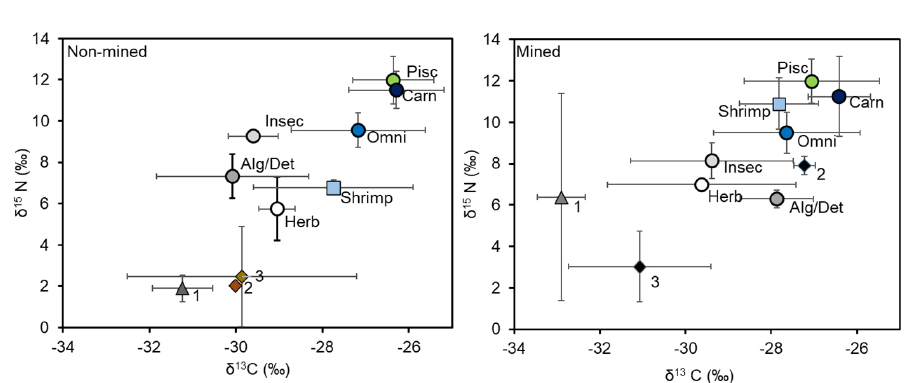
FIGURE 4 | Mean nitrogen ( δ 15N) and carbon ( δ 13C) isotope ratios of fish species collected from mined (right panel) and non-mined (left panel) sites in the Mazaruni River, Guyana. Species were grouped together based on their trophic guild. Each symbol represents the average of all species within each trophic guild. Numbers represent the basal resources collected at surveyed sites (1 = bryophyte, 2 = benthic algae, 3 = aquatic macrophytes). The abbreviations for the fish trophic guilds: Algivore/ Detritivore (Alg/Det), Insectivore (Insec), Herbivore (Herb), Omnivore (Omni), Carnivore (Carn), Piscivore (Pisc), as well as one shrimp ( Macrobrachium